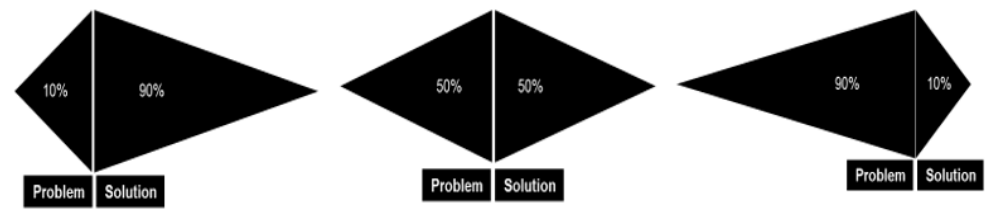
Figure 5. Cognitive Bias in the Exercise of Problem Solving (authors).